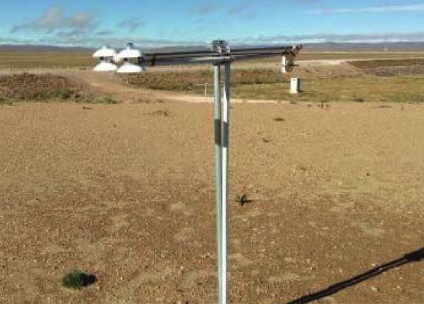
Figure 3: Observation station for recording solar radiation